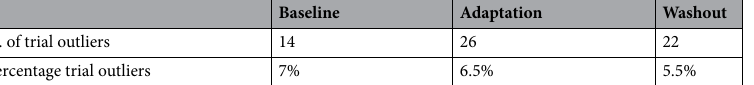
Table 2. Number of trial outliers discarded in all participants for each session of the second experiment on the basis of the computed Thickness . The Thickness threshold was set to the average value plus two times the standard